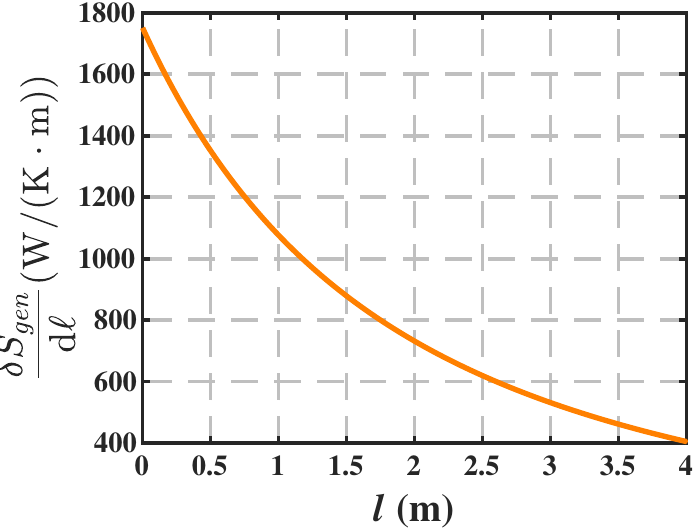
Figure 18. The local entropy generation profile of the above best